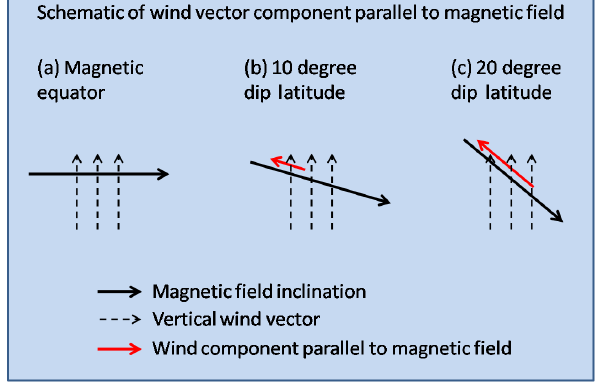
Figure 6. Schematic of magnetic field parallel component of verti- cal wind vector at (a) magnetic equator, (b) 10 ◦ dip latitude, and (c) 20 ◦ dip latitude. The direction of magnetic field and vertical wind vector is indicated as solid and dashed black line, respectively. The red line indicates the field parallel component of vertical wind vec- tor. As this component increases with dip latitude, the vertical wind associated with seismic infrasound will have a better efficiency to perturb the ionospheric densities at higher